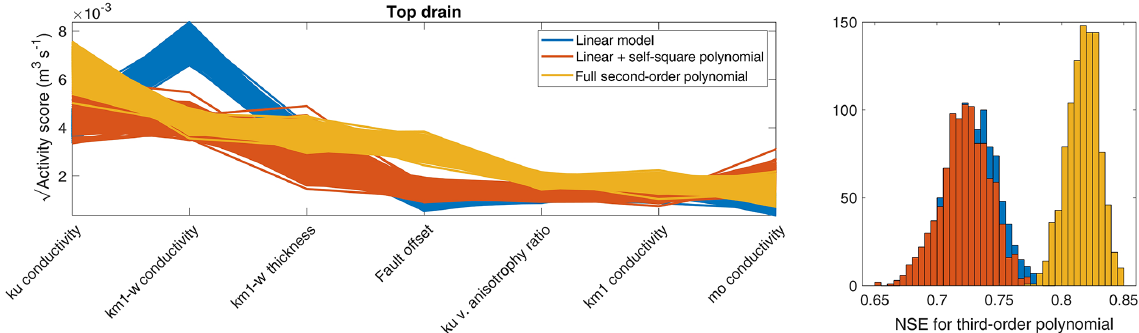
Figure A1. Square root of activity score and corresponding NSE for flooding flow across the top boundary using different approximations to compute the gradients. In this case, the bootstrap sample is drawn from the full sample population of 10000.